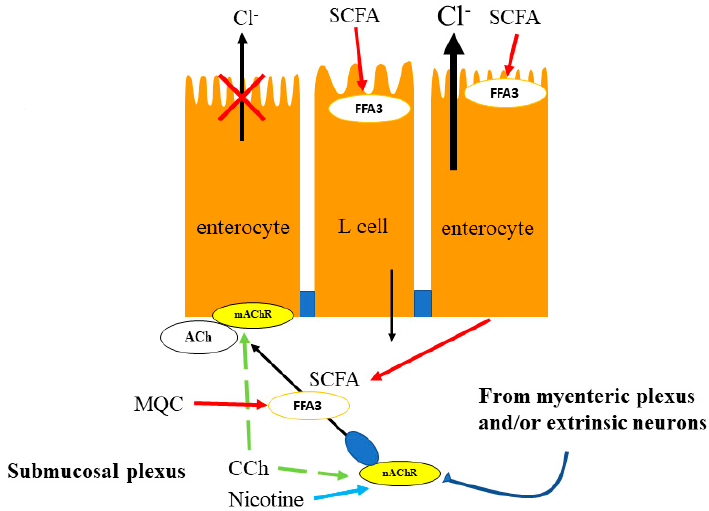
Figure 2. Proposed mechanism of SCFA sensing in the proximal colon. The proximal colonic mucosa is always exposed to high concentrations of microbial metabolite, SCFAs. Non-selective cholinergic agonist, CCh-induced Cl − secretion is decreased by TTX, C6 and the serosal FFA3 agonists, acetate or propionate. Serosal application of a selective FFA3 agonist, MQC also suppresses the response to CCh via the submucosal plexus but not to forskolin. Pretreatment with MQC inhibits nicotine-induced but not bethanechol-induced secretion. The major transmitter of fast excitatory transmission between neurons is ACh, that acts on post synaptic nicotinic receptors [84]. Therefore, cholinergic neuronal axons expressing FFA3 located in the submucosal plexus are possibly activated by CCh and nicotine, and release ACh. MQC or TTX does not affect CCh-evoked secretion in mucosal preparation, where submucosal neurons are eliminated suggesting that MQC has no direct interaction with muscarinic receptors expressed on epithelial cells. SCFA, short-chain fatty acid; TTX, tetrodotoxin; C6, hexamethonium; MQC, N -[2-methylphenyl]-[4-furan-3-yl]-2-methyl-5-oxo-1,4,5,6,7,8-hexahydro-quinoline-3-carboxamide; 5-HT, 5-hydroxytryptamine; ACh, acetylcholine; EC, enterochromaffin.